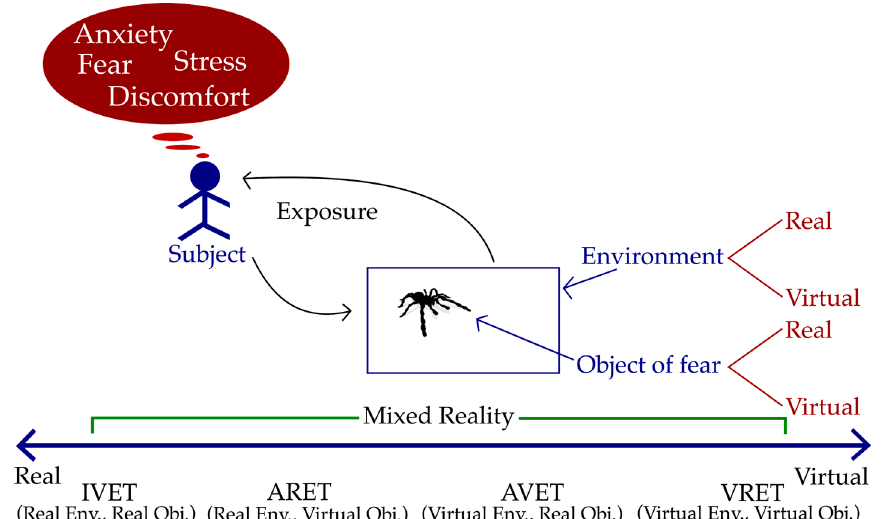
Figure 1. User experience in exposure therapies with Mixed Reality